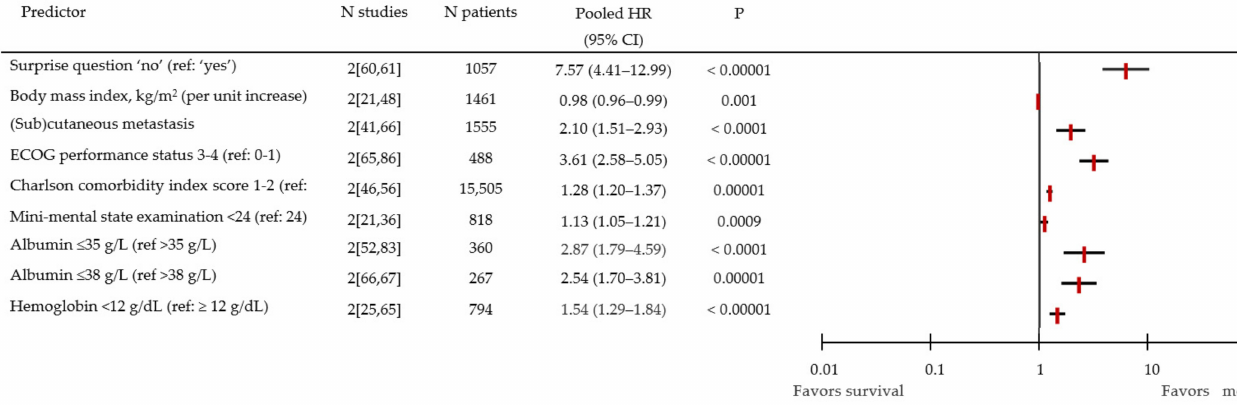
Figure 2. Forest plot of pooled hazard ratios for mortality with a fixed-effects model. CI: confidence interval; HR: hazard ratio; ECOG: Eastern Cooperative Oncology